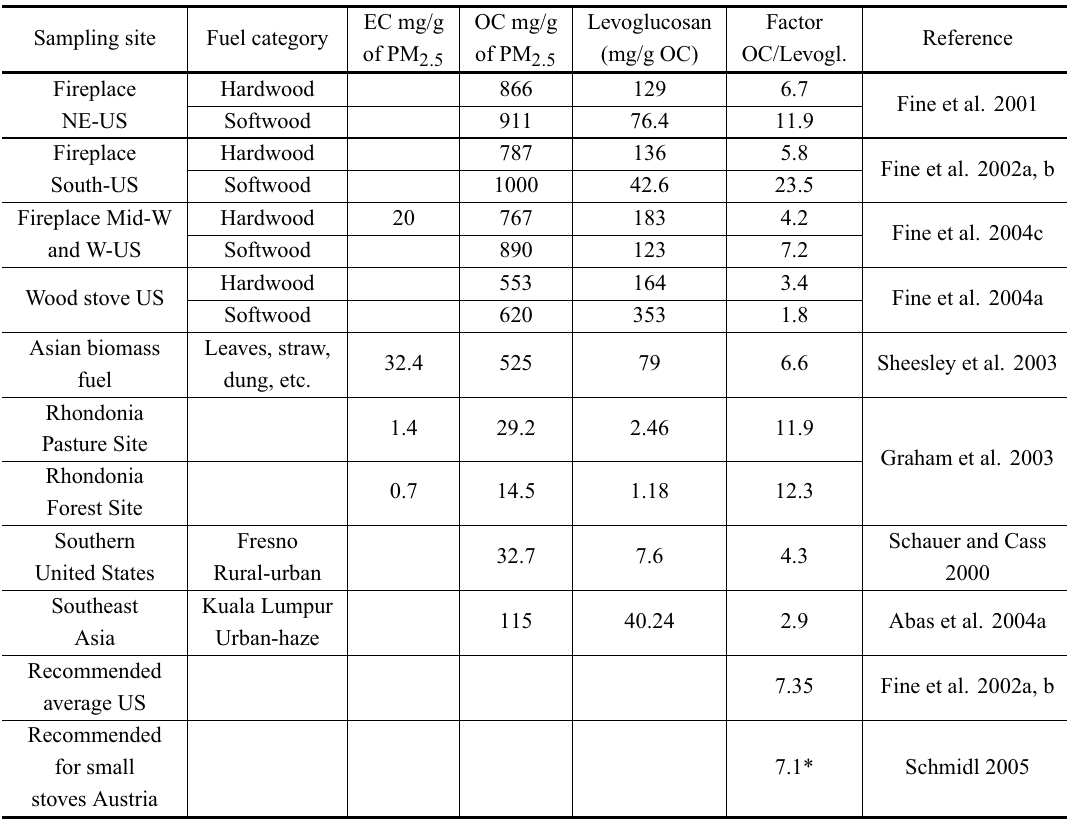
Elemental carbon, organic carbon and levoglucosan in fine particulate matter from different categories of biomass burning measured recently in different investigatios (adapted from Puxbaum et al. 2007). Sampling